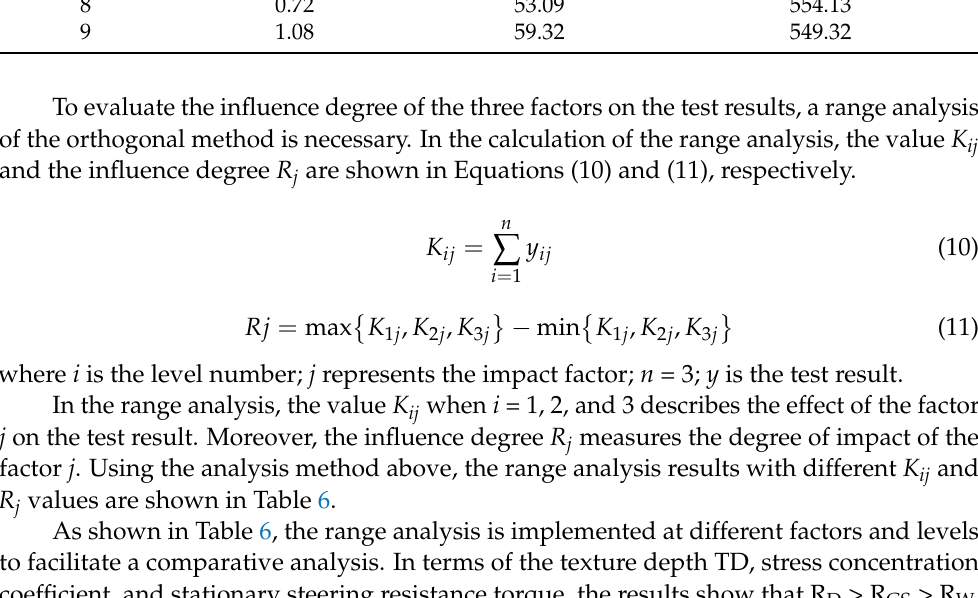
Table 5. Orthogonal test results.